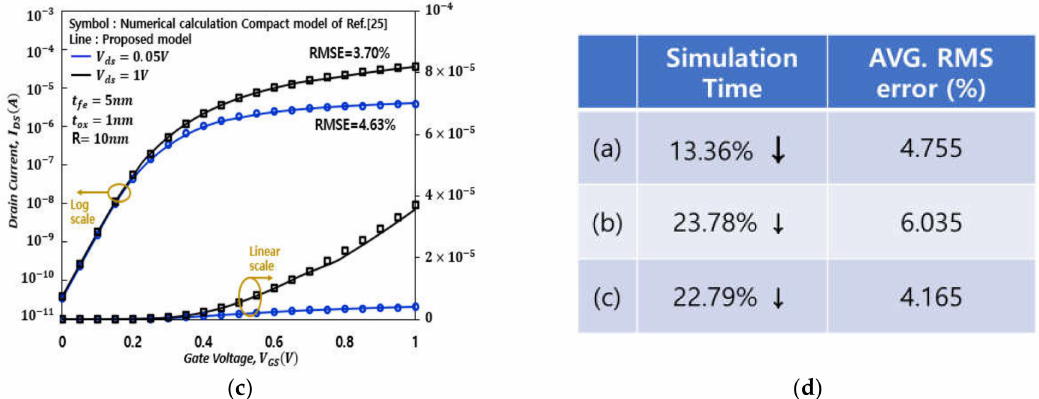
Figure 8. Comparison of I DS –V GS prediction results between the previous work [25] and this work for various geometry cases; ( a ) t fe = 8 nm, t ox = 3 nm, R = 10 nm, ( b ) t fe = 8 nm, t ox = 1 nm, R = 10 nm, ( c ) t fe = 5 nm, t ox = 1 nm, R = 10 nm, and ( d ) summary of simulation time and average root-mean-square (RMS) error.